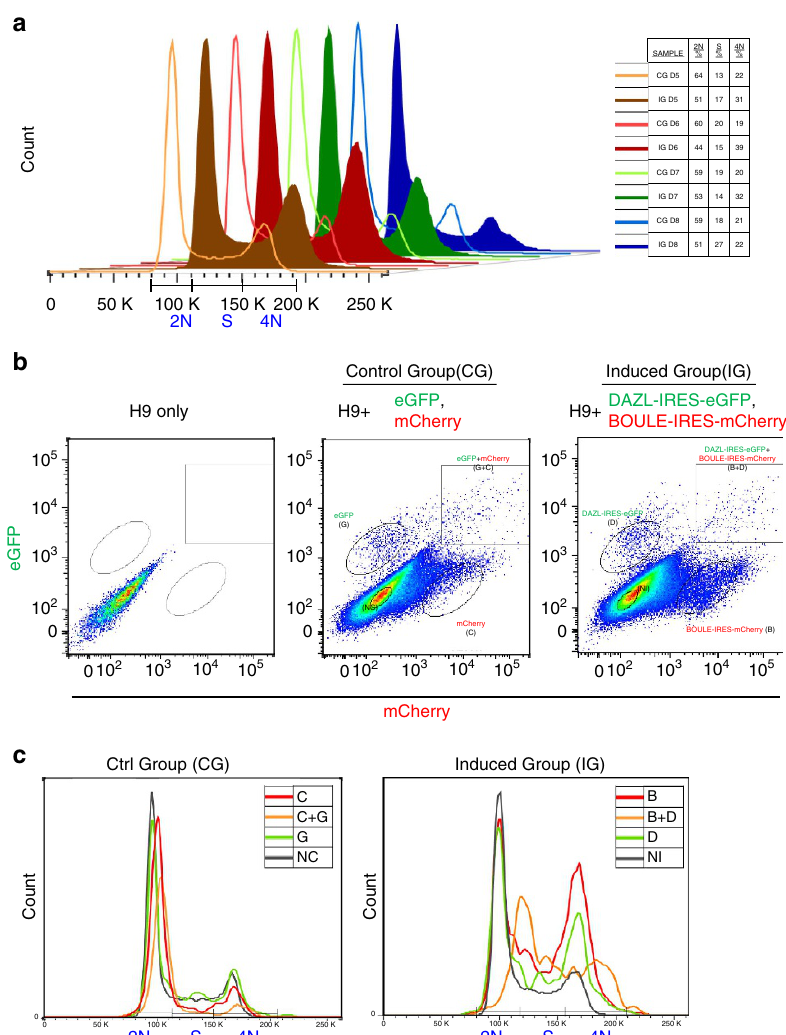
Figure 3 | 4n cells are enriched in cells with DAZL and BOULE overexpression. ( a ) DNA content analysis of hESCs transduced with control vectors eGFP and mCherry (control group, CG, line curves) or DAZL-IRES-eGFP and BOULE-IRES-mCherry vectors (induced group, IG, solid curves) from day 5 (D5) to day 8 (D8). In total, 4 500,000 cells were analysed for each sample. Right table shows corresponding percentage of 2n, S-phase and 4n cells in each sample. Three independent experiments were conducted. ( b ) FACS plots showing distinct populations expressing GFP, mCherry or both fluorescent proteins in either CG or IG groups. NC: cells without any fluorescent protein in CG, C: cells expressing mCherry, G: cells expressing eGFP, C þ G: cells expressing mCherry and eGFP, NI: cells without any fluorescent protein in IG, B: cells expressing BOULE-IRES-mCherry, D: cells expressing DAZL-IRES-eGFP, B þ D: cells expressing BOULE-IRES-mCherry and DAZL-IRES-eGFP. Cell populations were subdivided into different groups according to their expression of fluorescent proteins. ( c ) DNA-content profiles of subpopulations in CG and IG cells at